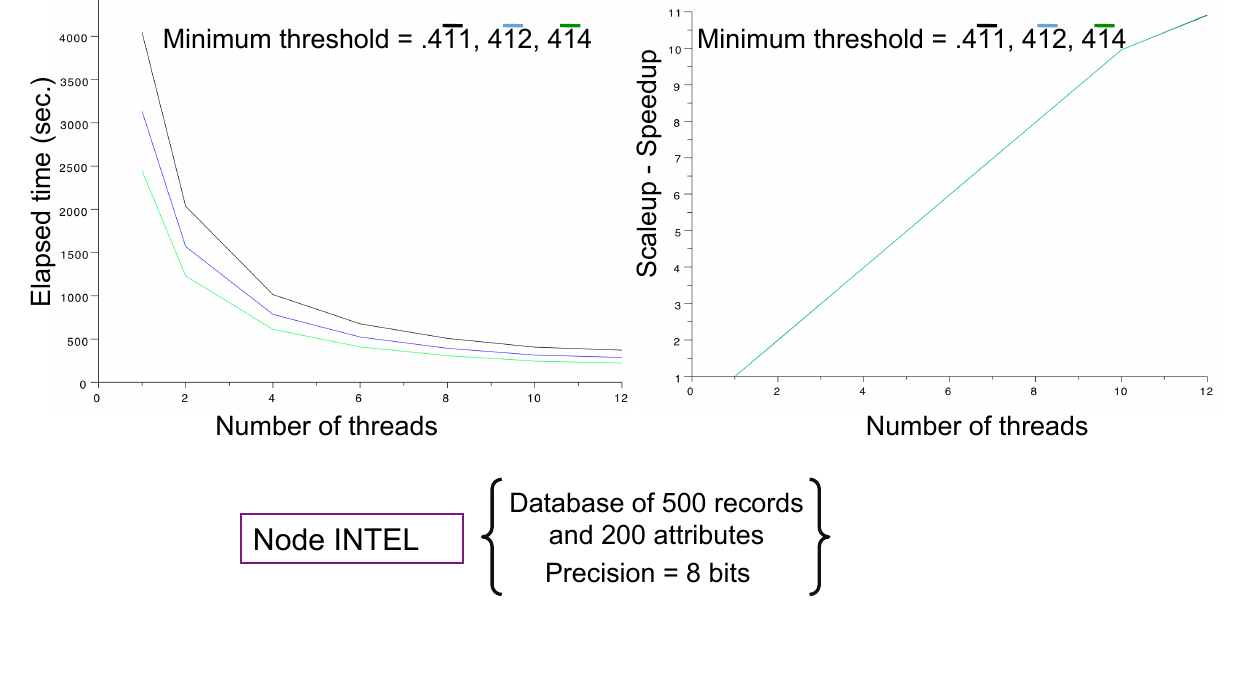
Figure 7. Execution time and Speedup related to the number of threads on Intel nodes for synthetic database of 200 attributes at precision 8 bits with minimum threshold values 0.411, 0.412 and